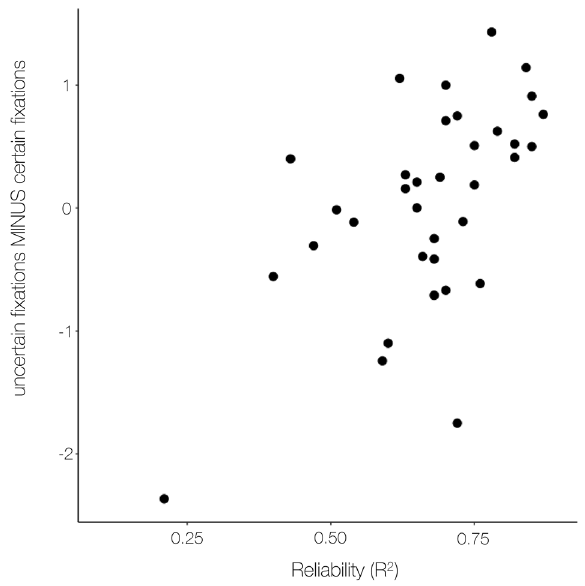
Figure 6. Association between reliability and the difference in fixations during certain and uncertain trials. For each participant, we computed a difference score by subtracting the average number of fixations during certain trials from the average number of fixations made during uncertain trials. The effect of certainty on fixations (y-axis) was significantly correlated with reliability (x-axis), the strength of the association between temperature and pain ( r = 0.57, p < .001). This association is still present, although weaker, when the outlier near the graph’s origin is removed ( r = 0.4, p = .02).